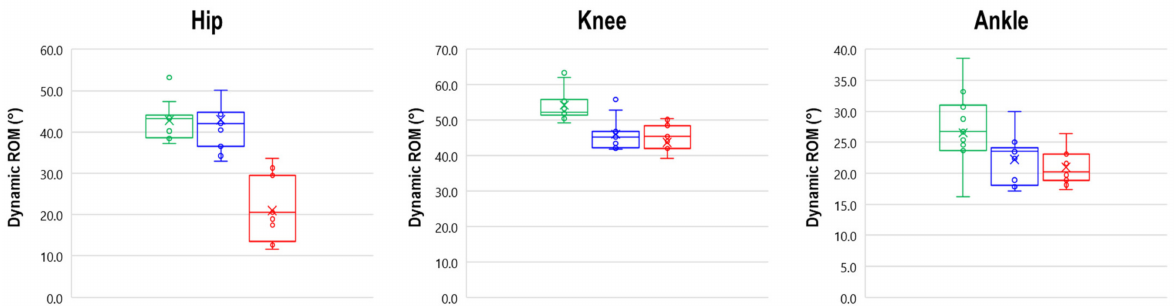
Figure 5. Box plots summarizing the dynamic ROM for hip, knee, and ankle joints. The green line represents the control group, the blue line represents the unaffected limb of individuals with OA, and the red line represents the affected limb of individuals with OA.